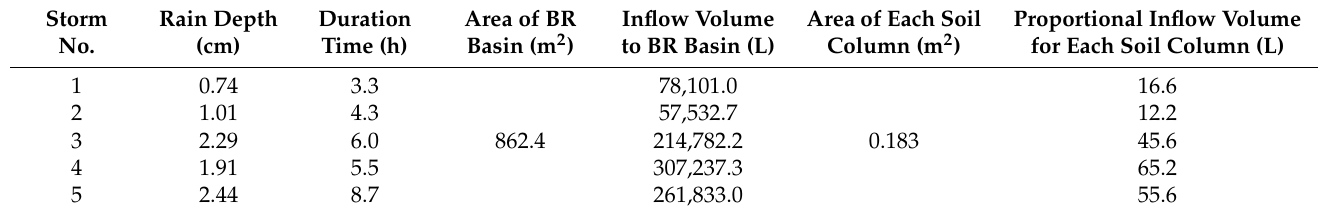
Table 2. Bioretention (BR) field rain and flow information of five representative monitored storm